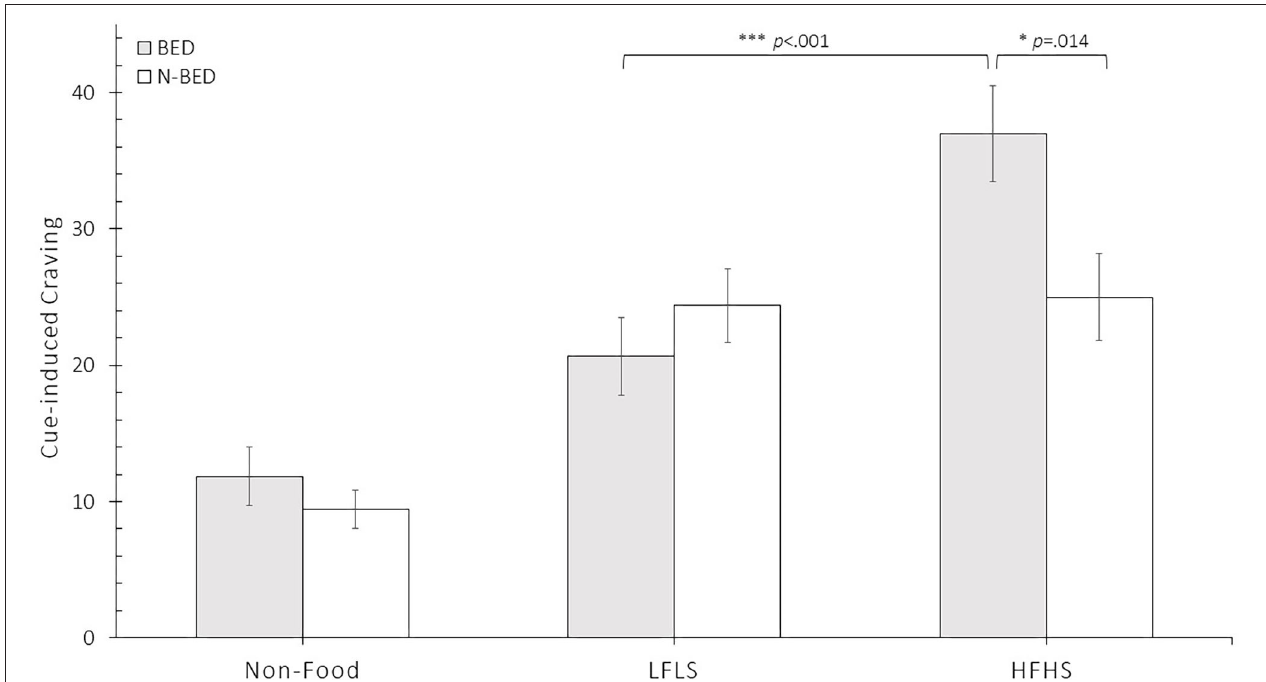
FIGURE 2 | Results of mean food craving ( ± SEM) separated for the group of individuals with obesity and binge eating disorder (BED) and the group of individuals with obesity without eating disorders (N-BED) in the three main categories of stimuli: Non-Food, low fat/low sugar (LFLS) and high fat and high sugar (HFHS). * p < 0.05, *** p <